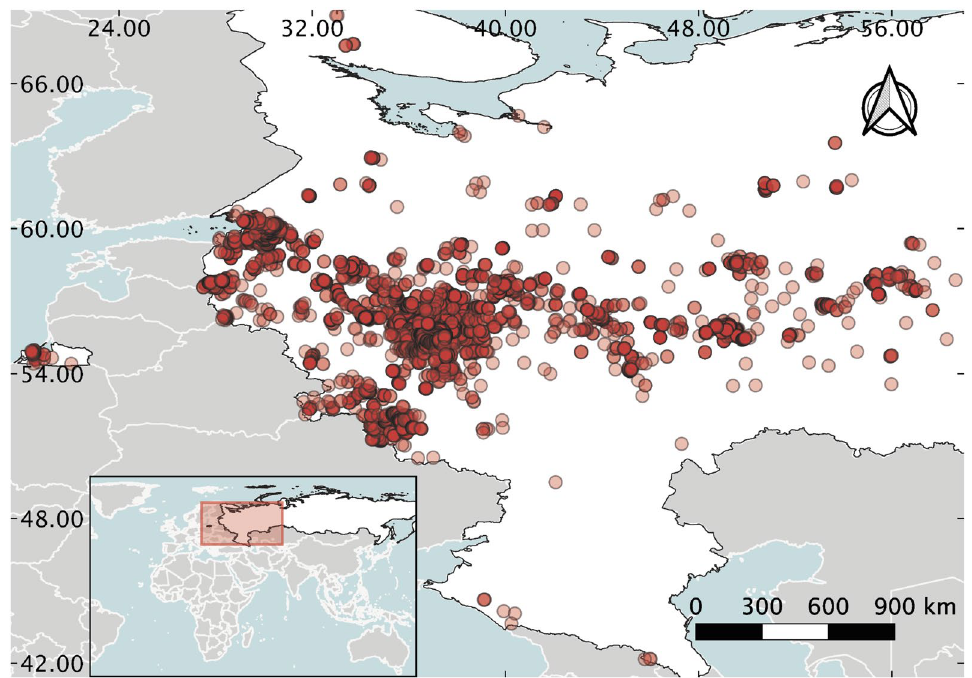
Figure 4. Map of the study area: white colour represents the territory used for prediction, red points correspond to the dataset of HS occurrence, collected from the available sources.